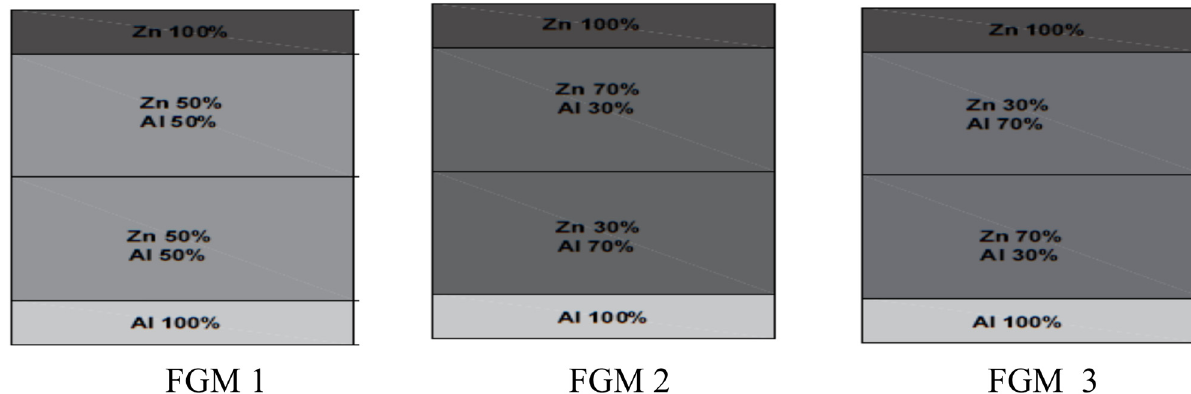
Figure 4: Models of FGMs ’